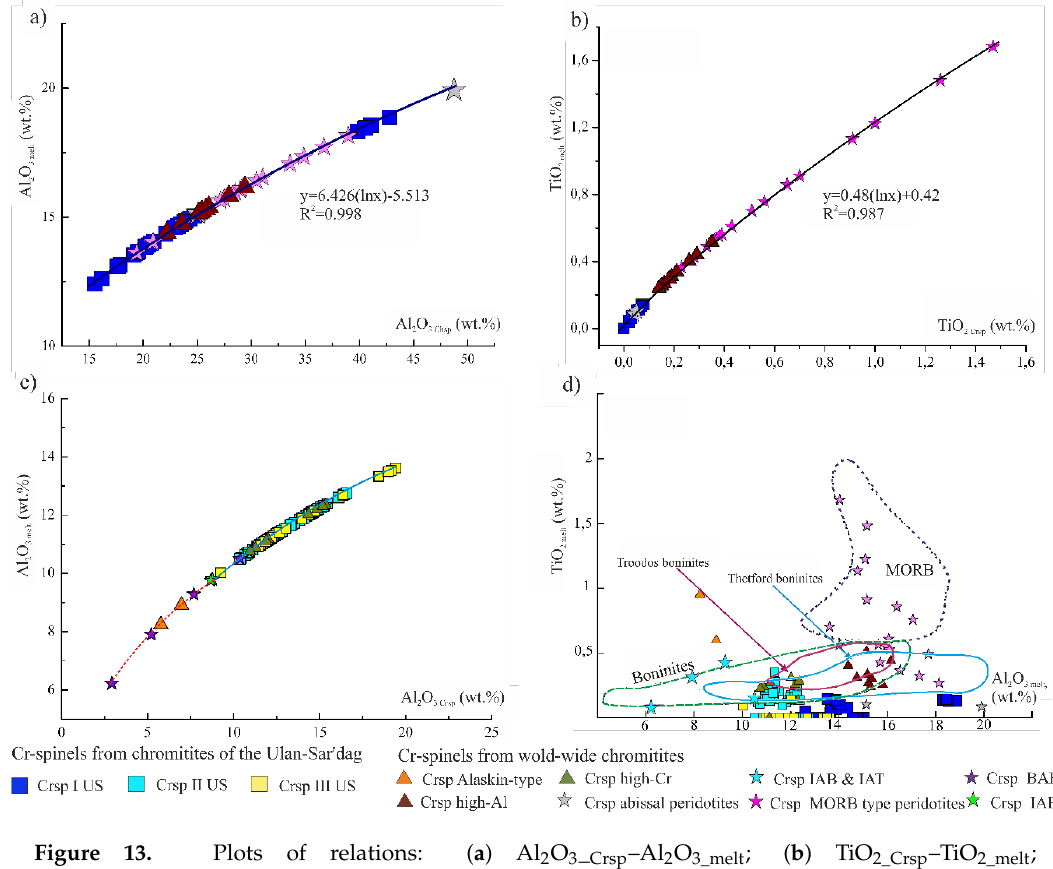
Figure 13. Plots of relations: ( a ) Al 2 O 3 _ Crsp –Al 2 O 3_melt ; ( b ) TiO 2_Crsp –TiO 2_melt ; ( c ) Al 2 O 3_Crsp –Al 2 O 3_melt ; ( d ) calculated abundance of Al 2 O 3 –TiO 2 in melt, as in the equilibrium with the Cr spinels from the